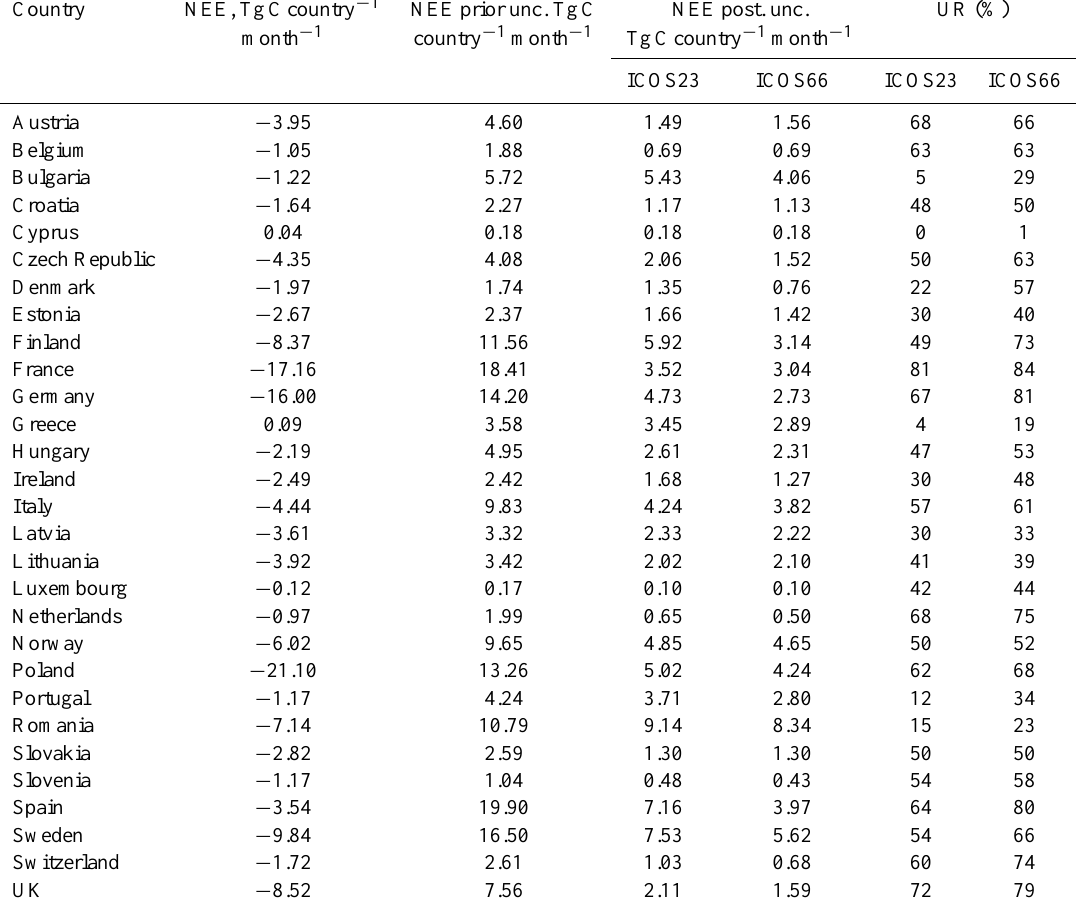
Table A2. NEE uncertainty budget for European countries for July 2007 estimated using the reference inversion configuration and different atmospheric CO 2 networks. Uncertainty reduction values (UR) are shown in the last two columns for ICOS23 and ICOS66.